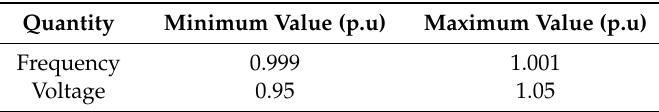
Table 1. MG acceptable operating limits.